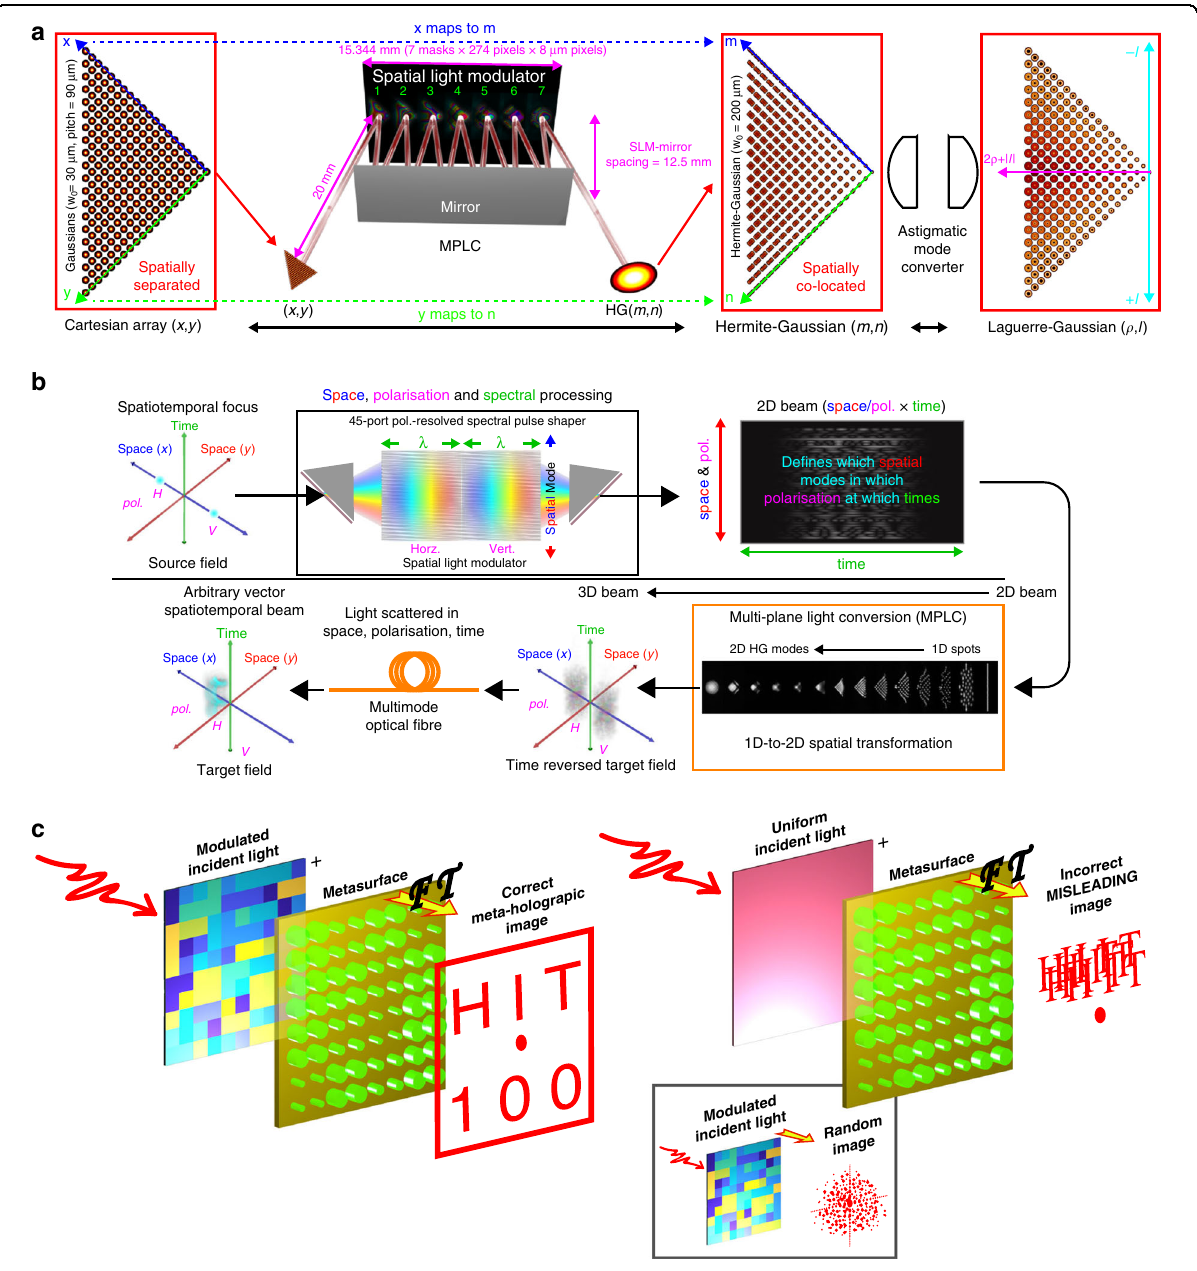
Fig. 3 MPLC-MVMs for optical signal processing. a Laguerre-Gaussian mode sorter 49 . b Arbitrary vector spatiotemporal fi eld generation 53 . c Optical encryption 55 . a Reprinted from ref. 49 with permission from Springer Nature: Nature Communications. b Reprinted from ref. 53 with permission from Springer Nature: Nature Communications. c Reprinted from ref. 55 with permission from Springer Nature: Nature